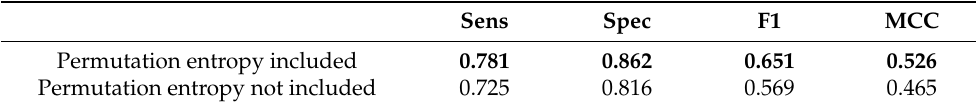
Table 3. The influence of permutation entropy on GBDT-PE. Sens Spec F1 MCC Permutation entropy included 0.766 Permutation entropy not included Table 4. The influence of permutation entropy on LightGBM-PE. Sens Spec F1 MCC Permutation entropy